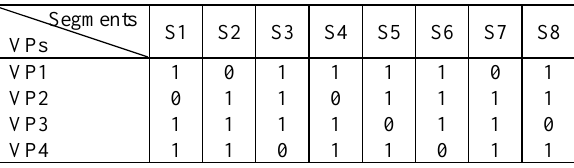
(b) Discretized data Figure 8. Layout of the experiment data